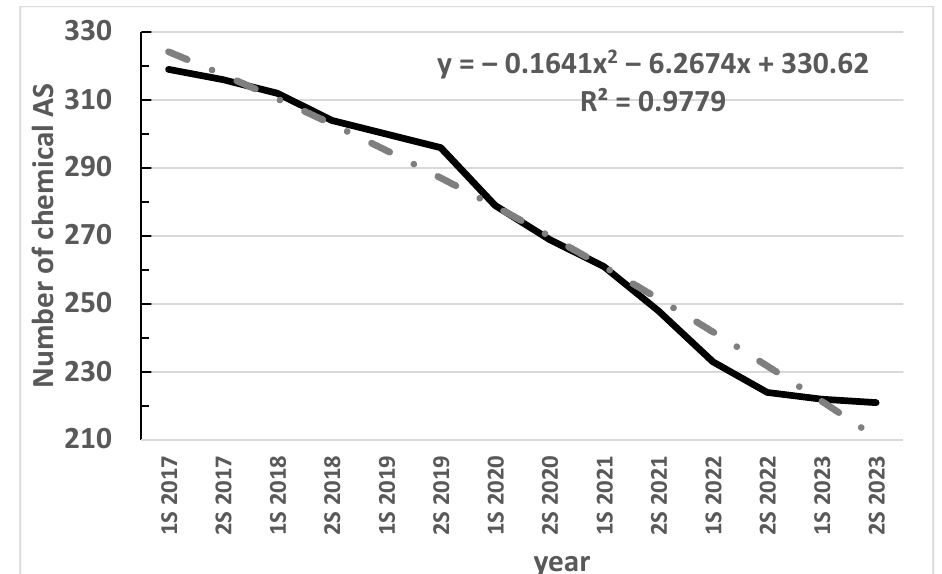
Figure 4. Hypothetical evolution of synthetic agrochemicals.